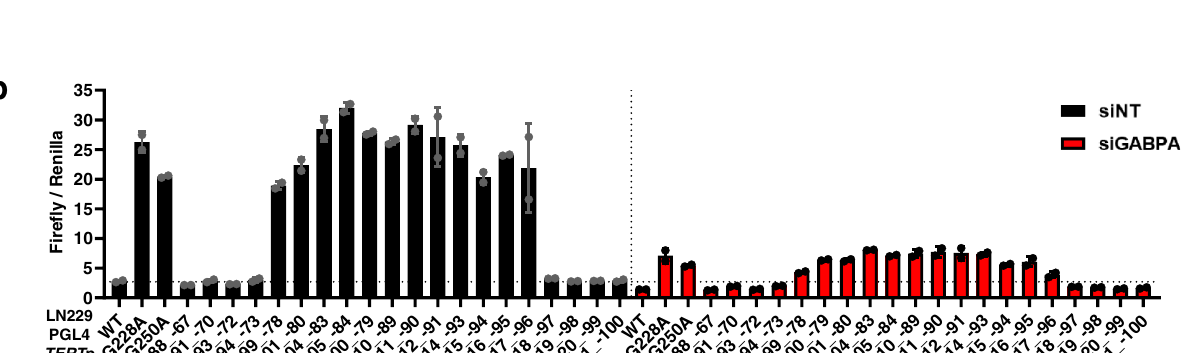
wildtype, two hotspot mutants and 20 duplication constructs representing 17 unique sequences 72h aftersiRNAknockdown of control or GABPA in LN229 cells. Values are mean and SD. N =2 independent experiments. TERT p TERT promoter, NT Non-targeting. Source data are provided as a Source Data fi